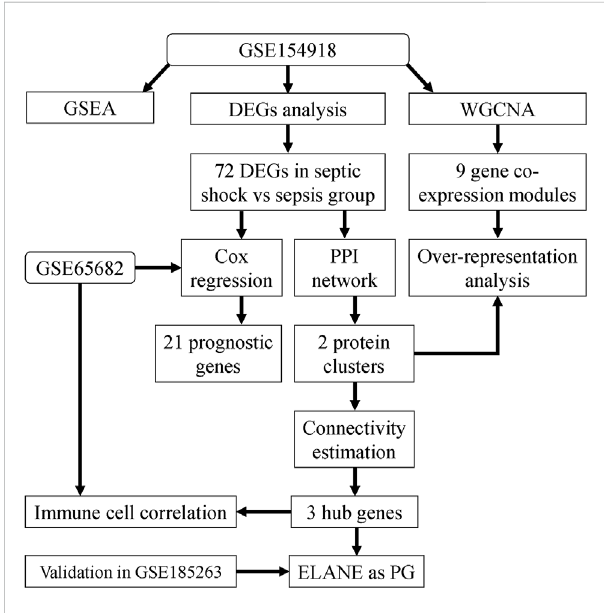
Study work fl ow. Bioinformatics analysis to screen core molecular mechanisms associated with septic shock and its high mortality. PPI, protein-protein interaction networks; GSEA, gene set enrichment analysis; WGCNA, weighted gene co-expression network analysis; DEG, Differential expressed gene; PG, prognostic